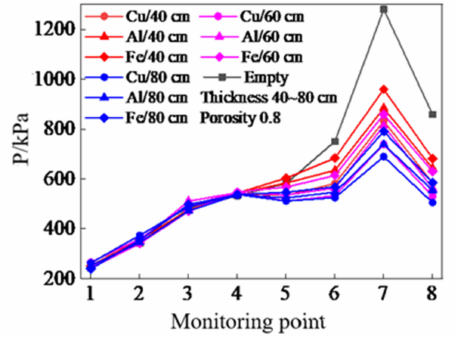
Figure 12. Maximum overpressure at each monitoring